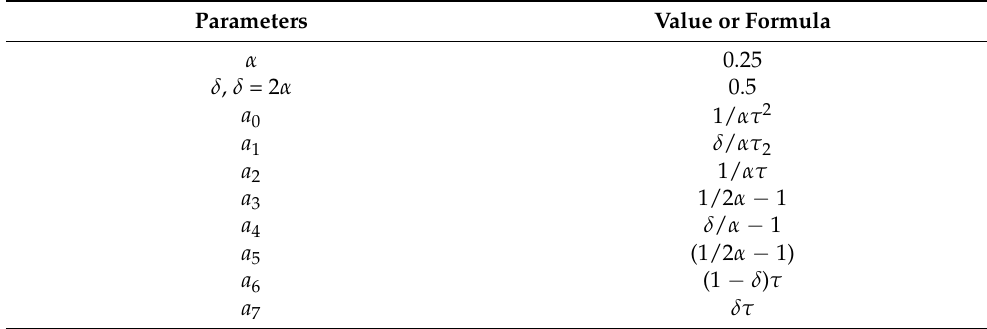
Table 1. Integration constant parameters of Newmark- β method. Parameters Value or